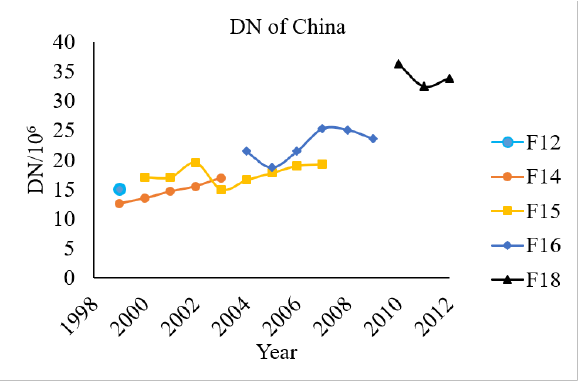
Figure 1. Sum of DNs in China during 1999-2012 from five different satellites